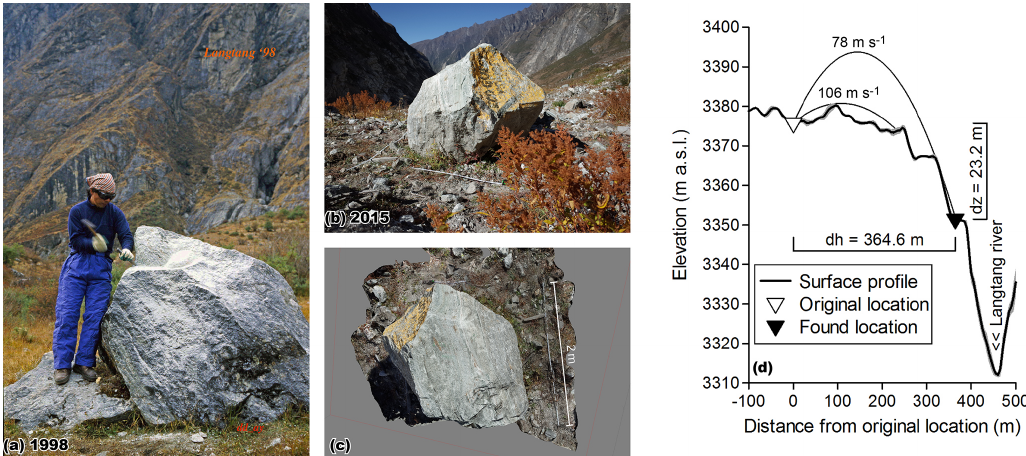
Figure 7. Photographs of the “cheese boulder”: (a) when the sculpture was carved in 1998; (b) during our in situ observation (22 Octo- ber 2015); and (c) from the structure from motion analysis with the similar angle of (a) . (d) Cross-section profile along which the boulder moved. Locations (Fig. 2a) and the surface profile were obtained by dGPS survey and the UAV SfM products. Elevation error is calculated based on the UAV DEM (1m resolution) by computing a standard deviation within a 5m distance. Thin parabolic curves denote possible passes, along which the boulder was blown. The higher curve does not touch the ground between the original and found locations while the lower curve can cross the 4.5m height hill, and then the boulder could roll down. Also shown are the initial speeds at the original location for the boulder to have the